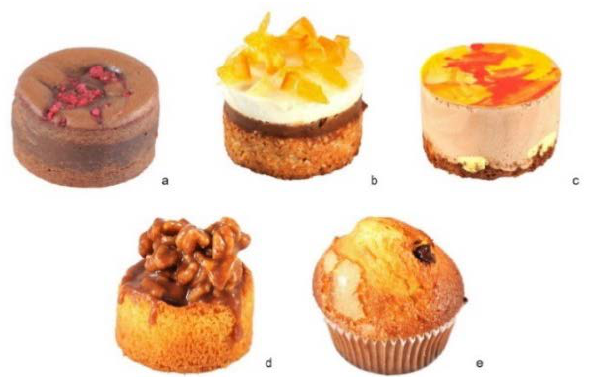
Figure 1. Stimuli designed by “Casa La Curra”: ( a ) Coulan (CC), ( b ) Leonor cake (LC), ( c ) Saffron cake (SC), ( d ) Walnut cake (WC), and ( e ) Chocomuffin (CM). Pictures were taken with a Nikon D200 camera with Nikkor 24–70 mm f/2.8S objective (Nikon Corporation, Tokyo, Japan). A white uniform background and three led panel light Neewer (Shenzhen Neewer Technology Co., Shenzhen, China) were used to ensure constant lighting conditions in the